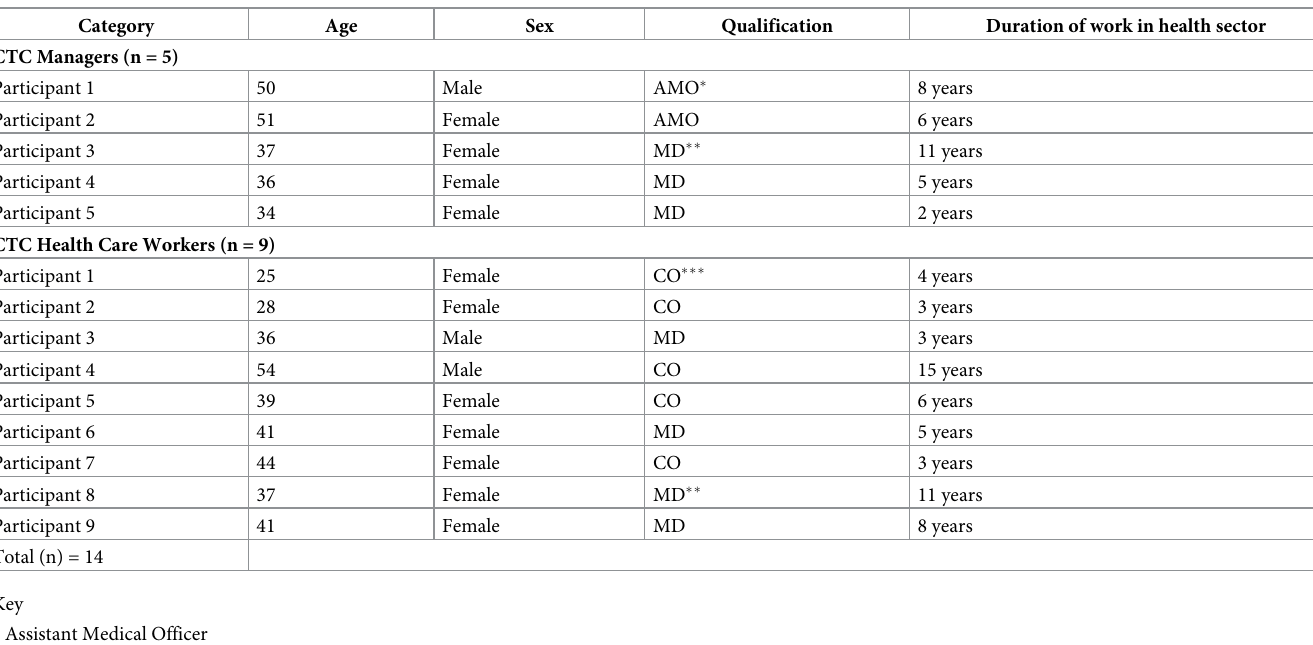
Table 3. Socio- demographic characteristics of CTC managers and direct health care providers (DHCP) in HIV CTCs in 2020, Dar es Salaam, Tanzania (N = 14).